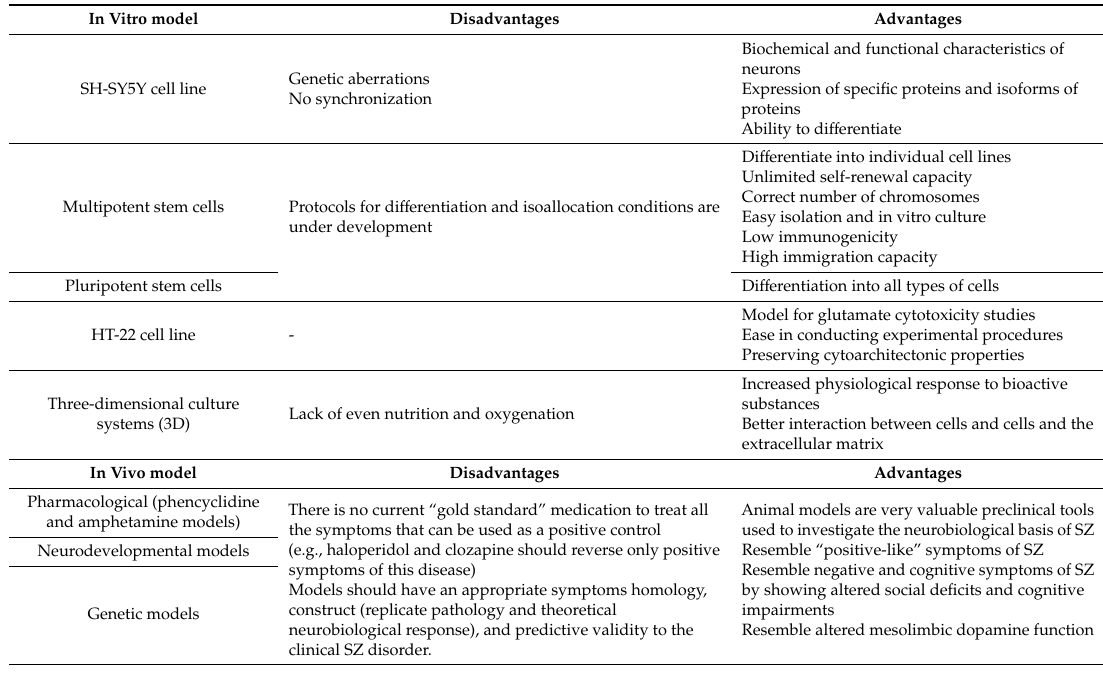
Table 2. Advantages and disadvantages of in vitro and in vivo models of SZ (partially elaborated based on reference